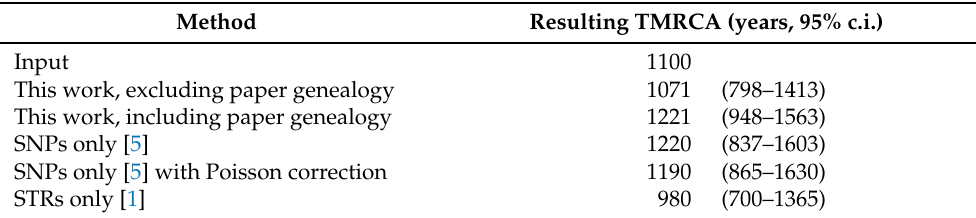
Table 3. Results for age of “Emn” in Example